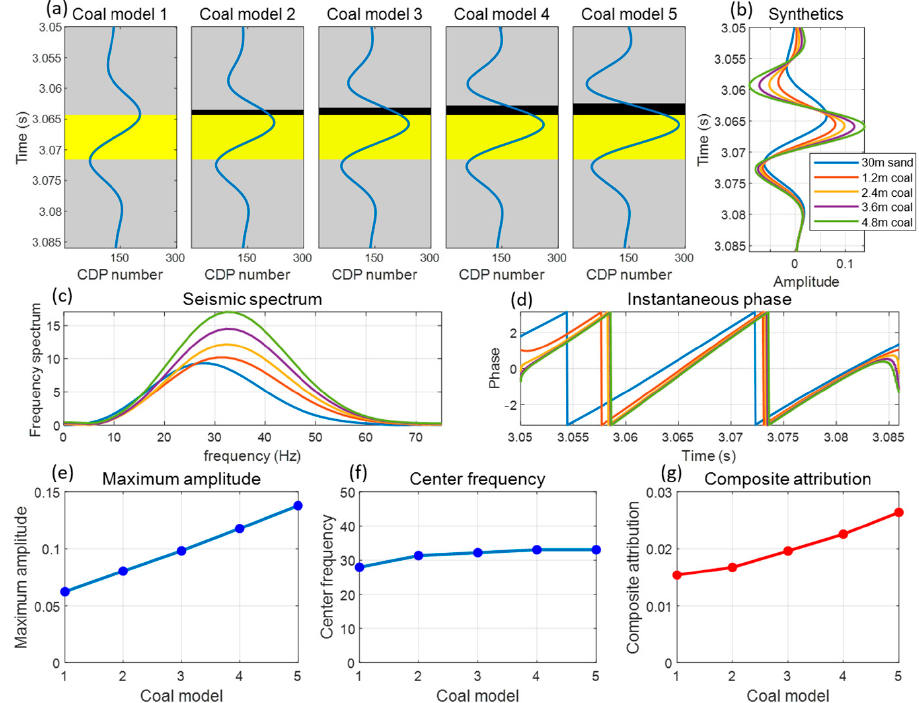
Figure 4. Model of thin coal seams coupled with sandstone and its synthetics and attributes: ( a ) coal model, ( b ) synthetic, ( c ) seismic frequency spectrum, ( d ) instantaneous phase, ( e ) maximum ampli- tude, ( f ) centre frequency, and ( g ) composite attribute.